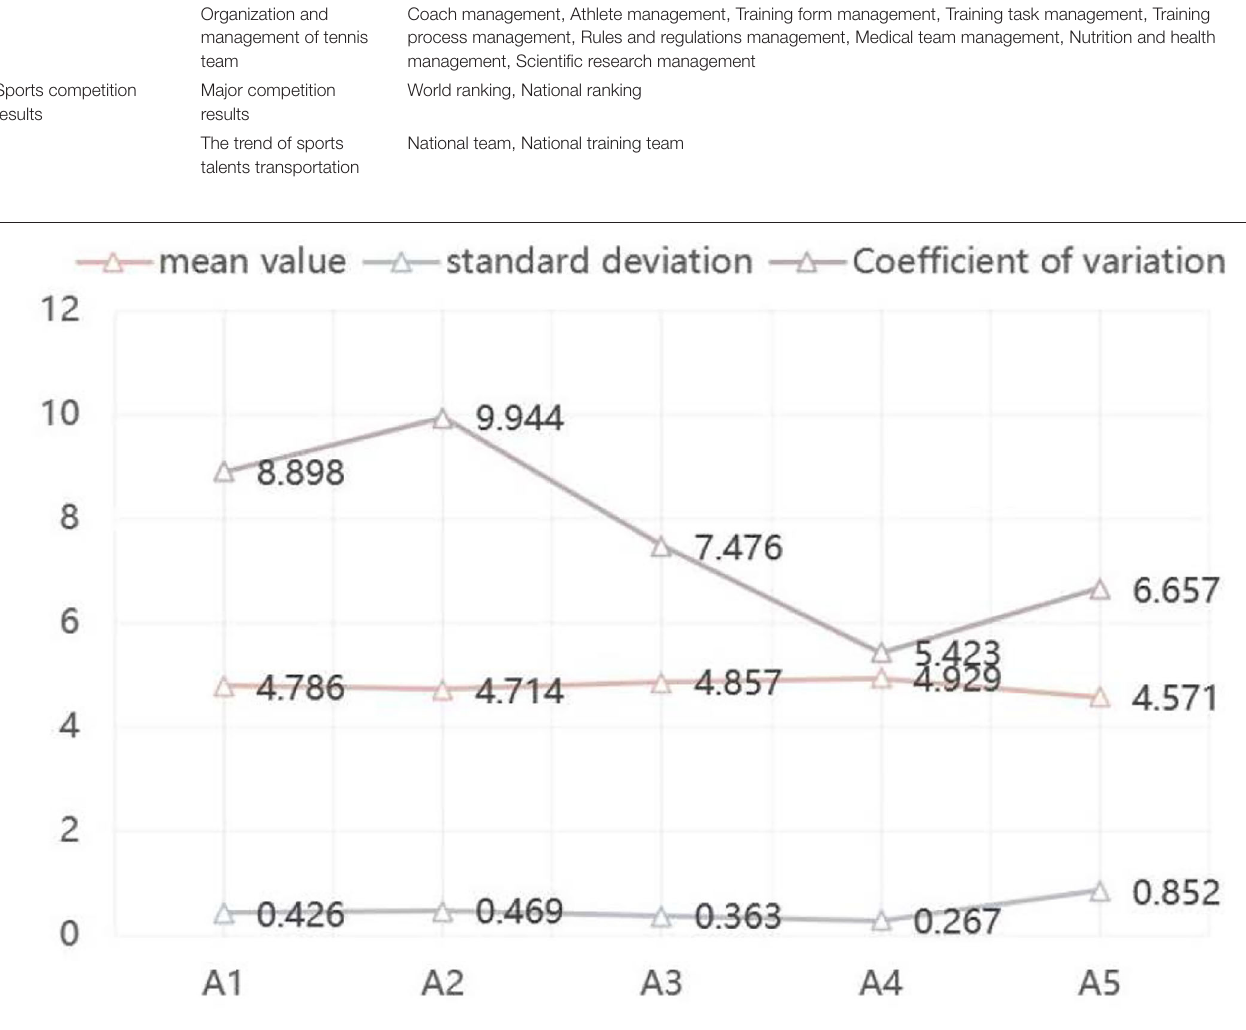
(A1), training implementation (A2), training monitoring (A3), work management (A4), and competition performance